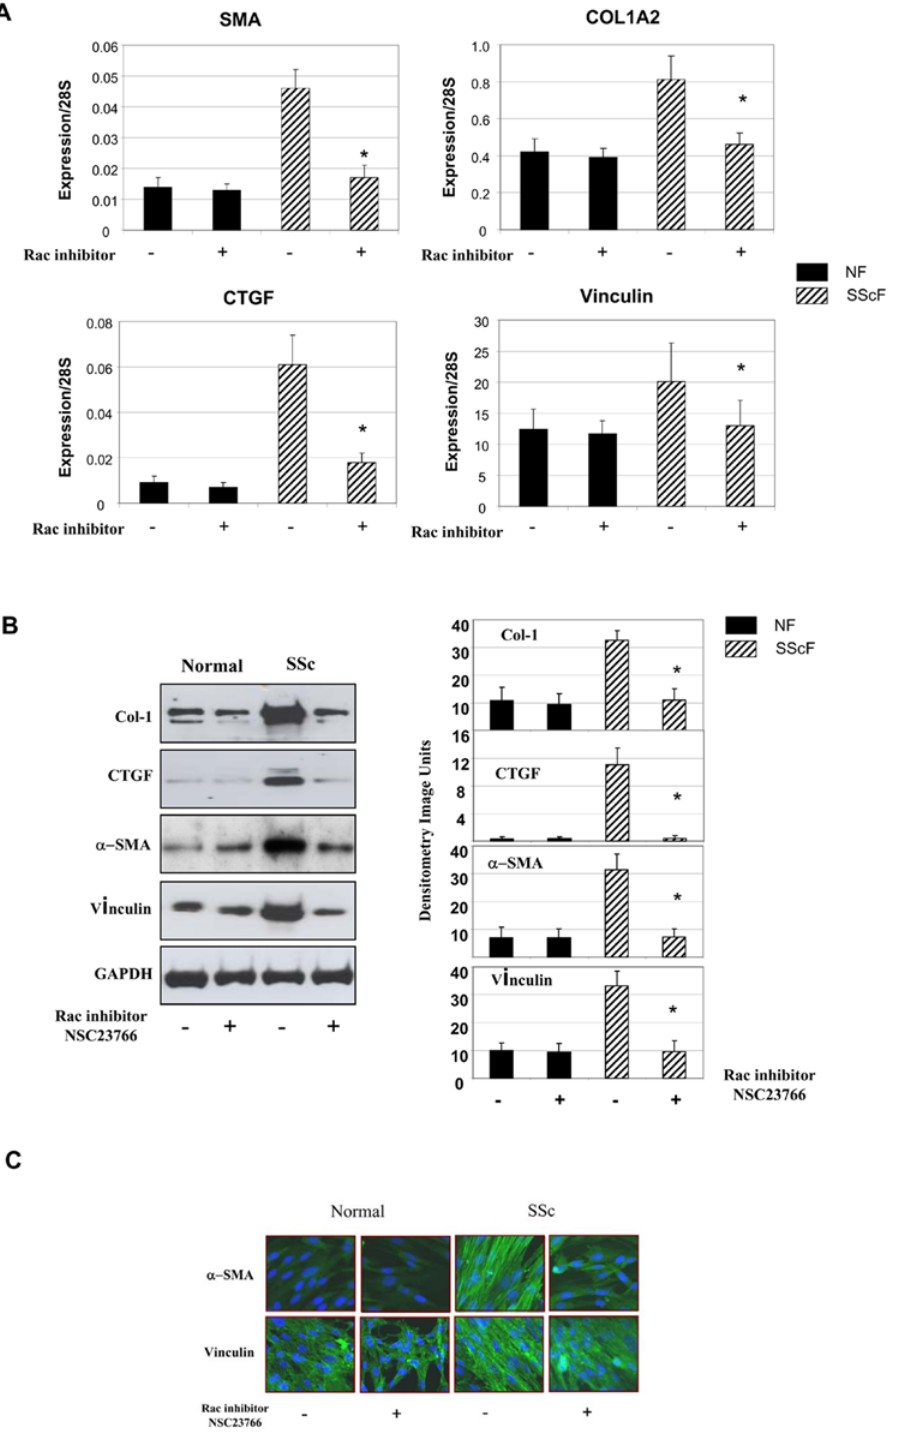
Figure 2. Rac inhibition suppresses the pro-fibrotic phenotype of lesional SSc fibroblasts. mRNA and protein analysis. Fibroblasts were from normal individuals (NF) and individuals with SSc (SScF) were assessed in the presence or absence of the rac-specific inhibitor (NSC23766, 24 hour treatment 50 m M). (A) Real-time PCR analysis. Messenger RNA was harvested from cells and subjected to real-time PCR analysis to detect the mRNAs indicated. Fibroblasts from 6 individuals were analyzed. Data represent averages and standard deviation. As a control, 28S RNA was amplified. Average of three replicates from three separate individuals, adjusted for 28S RNA expression values, are shown ( + / 2 SD *= p , 0.05 significant inhibition by NSC23766 compared to untreated controls, Student’s paired t test). (B) Western blot analysis. Proteins were harvested and subjected to Western blot analysis with antibodies directed against the proteins indicated. Densitometry is on the right ( + / 2 SD, *= p , 0.05 significant inhibition by NSC23766 compared to untreated controls, Student’s paired t test) (C) Immunofluorescence analysis. Cells were fixed and stained with anti- vinculin antibody to detect focal adhesion and rhodamine phalloidin to detect actin and a -SMA.